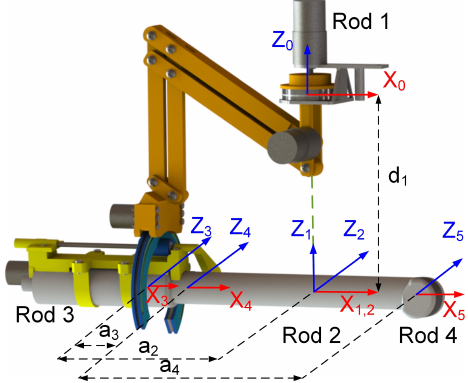
Figure 8. The kinematics coordinate